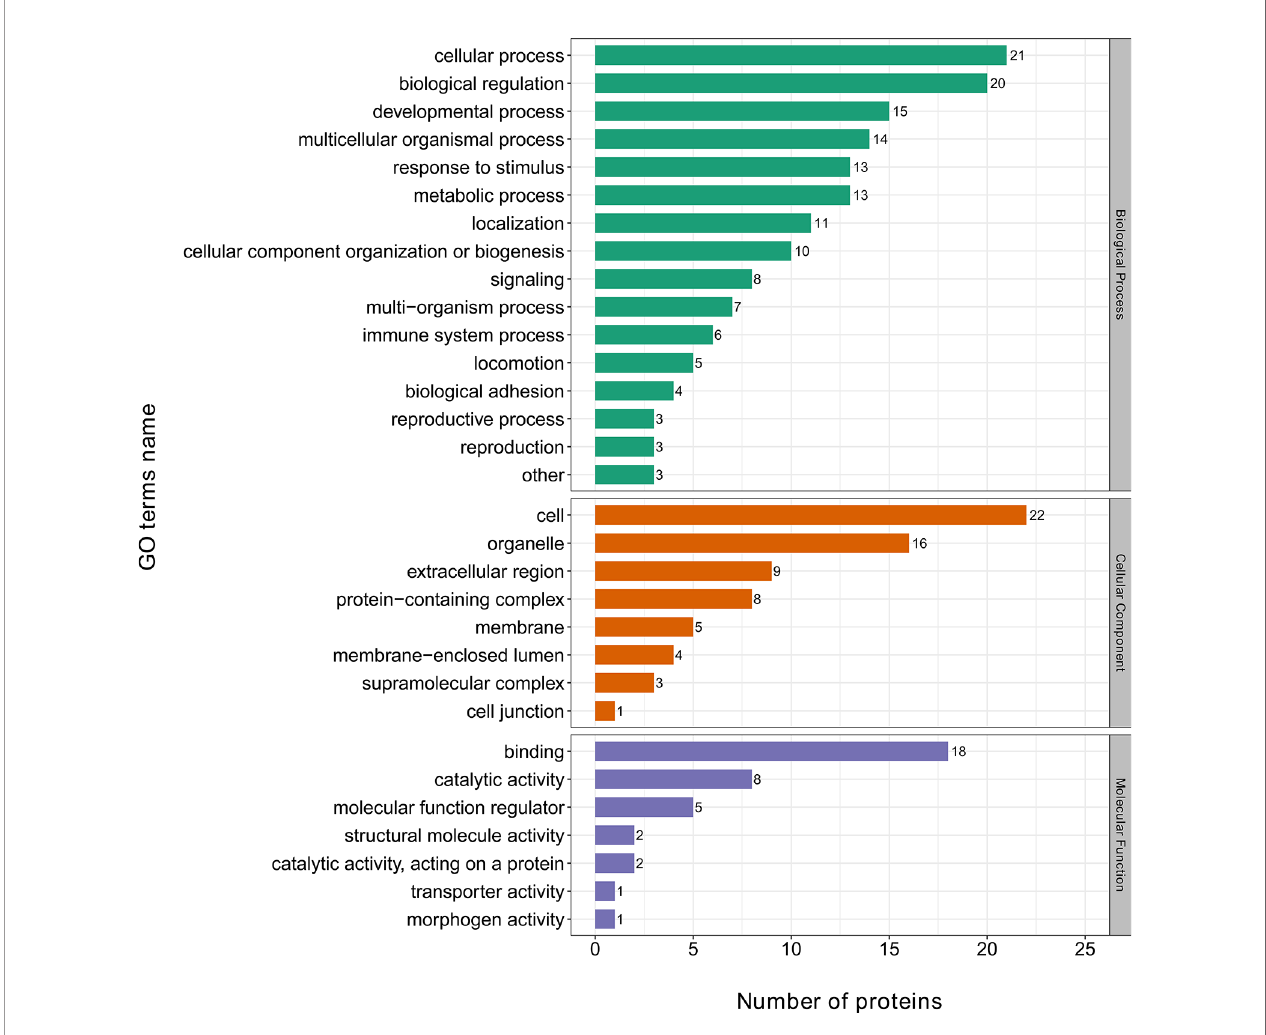
FIGURE 3 | Gene ontology (GO) analysis of differentially expressed